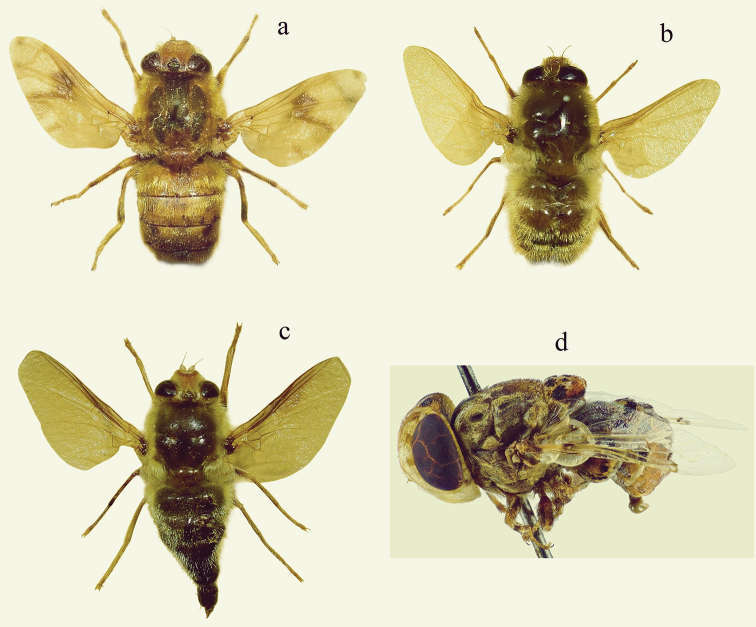
aGasterophilus
intestinalis (habitus, dorsal) bG.
nasalis (habitus, dorsal) cG.
nigricornis (habitus, dorsal) dCephalopina
titillator (habitus, lateral).